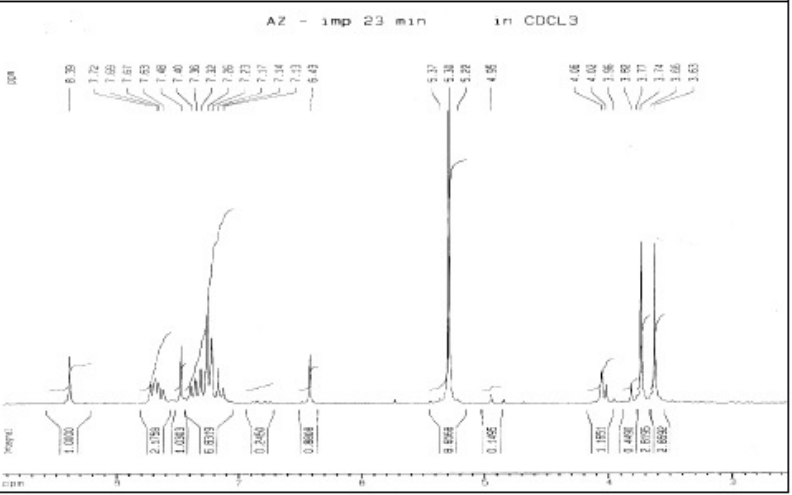
Figure 5. 1 H NMR spectrum of impurity